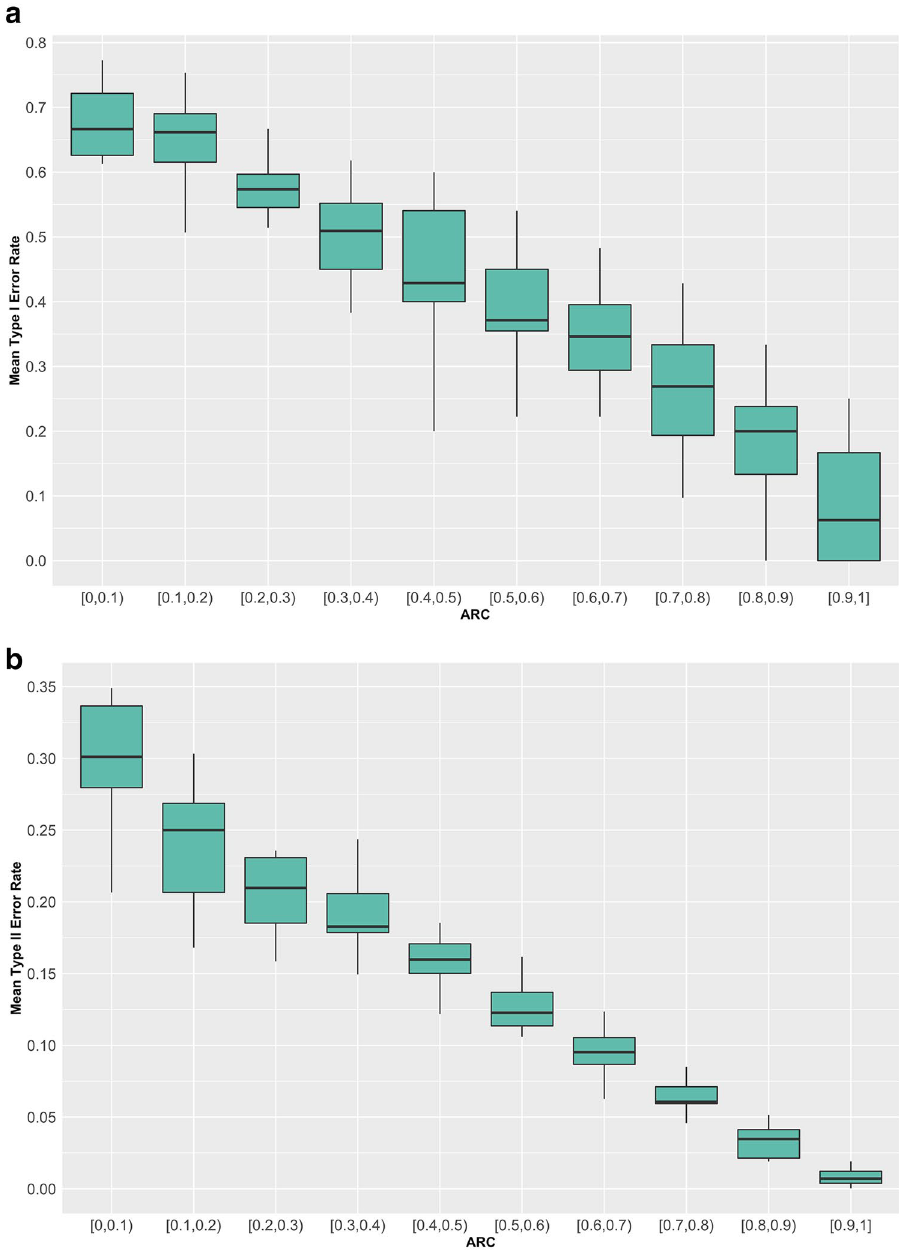
Figure 3. ( a ) Type I error rate against different ARC values. ( b ) Type II error rate against different ARC values.